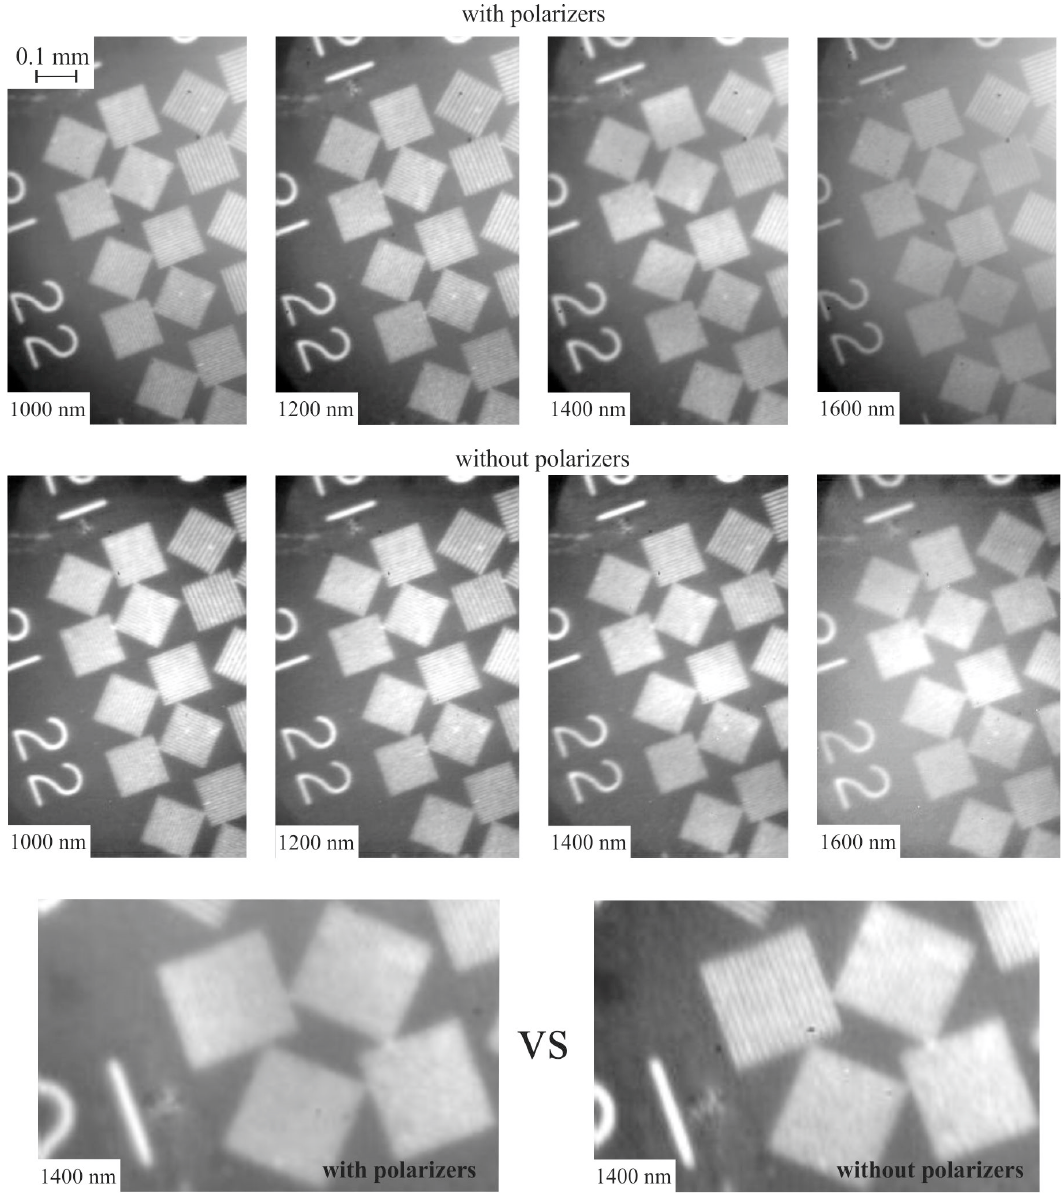
Figure 7. SWIR spectral images of the test chart in the conventional AOTF scheme with polarizers ( top ), and in the polarizer-free scheme ( middle ). Magnified view ( bottom ) for comparison. To test the system for biomedical applications, we acquired a series of 22 spectral images of a human elbow pit illuminated by an incandescent lamp (Figure 8a–e). The reflectivity spectrum of the region of interest (ROI) was calculated as a ratio of the brightness of each spectral image, averaged over ROI for and normalizing upon the spectral brightness of a white sheet of paper illuminated by the lamp. The spectrum of the human arm measured by the developed system (Figure 8f) exhibits key features of a human skin spectrum demonstrated earlier